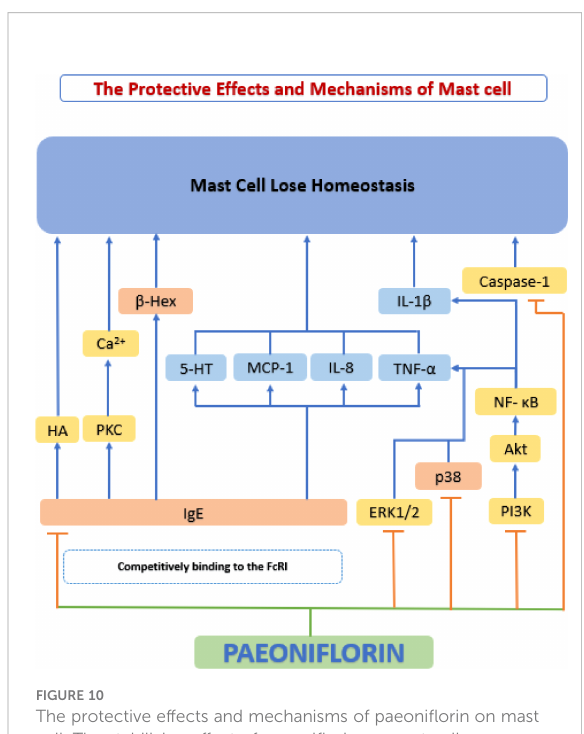
FIGURE 10 The protective effects and mechanisms of paeoni fl orin on mast cell. The stabilizing effect of paeoni fl orin on mast cells appears to be a promising new mechanism for the inhibition of atherosclerosis. 5-HT, 5-hydroxytryptamine; Akt, serine- threonine kinase; Ca2+, calcium2+; FcRI, high-af fi nity receptors for IgE; HA, histamine; IL-8, interleukin 8; IL-1 b , interleukin 1 b ; MCP-1, monocyte chemoattractant protein-1; NF- k B, the nuclear factor-kB; PI3K, phosphatidylinositol-4,5-bisphosphate 3-kinase; PKC, protein kinase